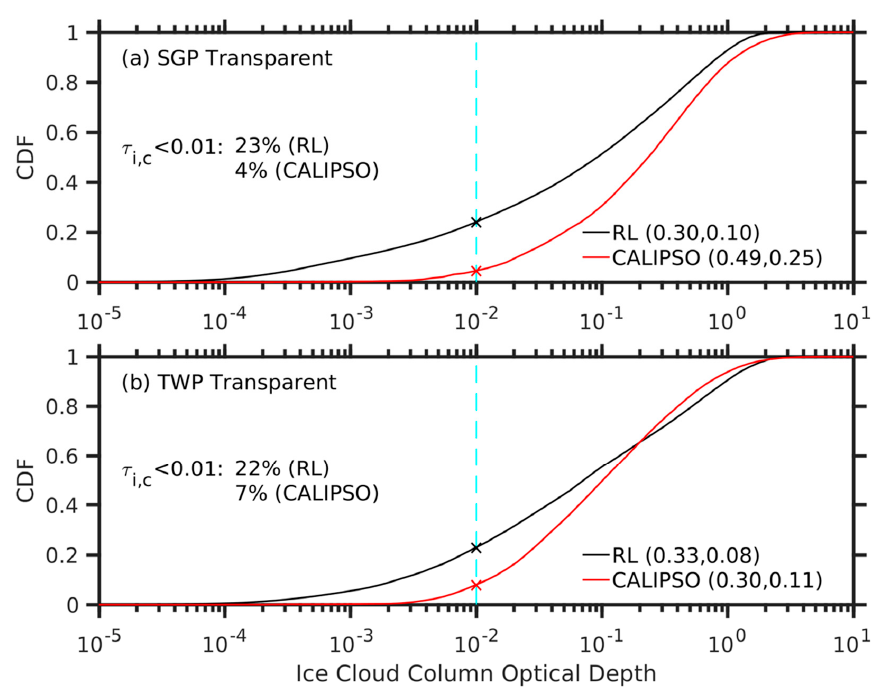
Figure 3. Cumulative distribution functions (CDFs) of ice cloud column optical depths for transparent ice cloud profiles from CALIPSO (red) and RL with CALIPSO-like extinction retrieval resolution (i.e., 8 min/60 m at SGP and 24 min/60 m at the Tropical Western Pacific (TWP) site) (black) for the ( a ) SGP and the ( b ) TWP sites. The percentages of the distribution below the ice cloud column optical depth of 0.01 (cyan line) are shown as “x” and the percentage values are given on the left. Mean and median values are given in the parentheses. Data for the RL at the SGP site are from August 2008 to August 2016 and at the TWP site from December 2010 to January 2015. Data for CALIPSO for both the SGP and TWP sites are from June 2006 to August 2016. Table 1. Number of total available profiles, transparent profiles, and transparent ice cloud profiles (i.e., transparent profiles where ice clouds are detected) for the RL and CALIPSO at the SGP and TWP sites. For the transparent ice cloud profiles, the number of profiles with ice cloud column optical depths greater than 0 (i.e., all transparent ice cloud profiles), less than 0.01, less than 0.005 and less than 0.001 are given. The numbers in the parentheses are the fraction relative to the number of all transparent ice cloud profiles. Data for the RL at the SGP site are from August 2008 to August 2016